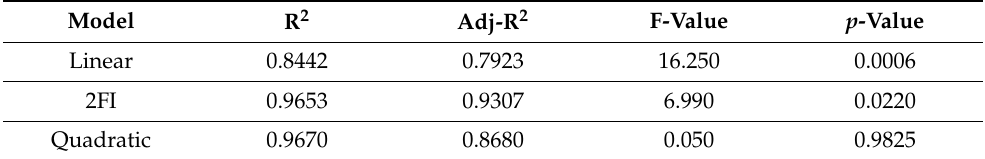
Table 2. Model summary